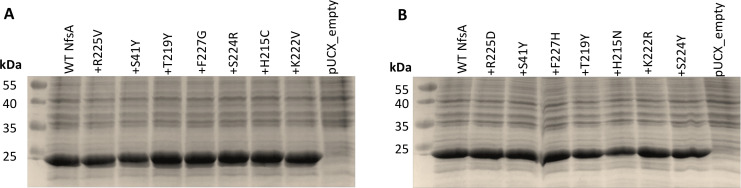
Relative enzyme expression levels for key intermediates from the most plausible hypothetical evolutionary trajectories for (A) 36_37 and (B) 20_39.Overnight E. coli 7NT cultures expressing pUCX::nfsA constructs were used to inoculate LB medium amended with 50 µM IPTG and incubated for 6.5 hr at 30°C. Samples were normalised based on cell density (OD600). On each gel, lysate from the cells expressing wild-type nfsA was loaded in the left-most lane relative to the markers, then the strain expressing the R225V/D mutant, then the S41Y R225V/D double mutant, and so on, as indicated by the labels denoting each successive substitution. An E. coli strain bearing empty pUCX was included in the right-most lane of each gel as a negative control. The predicted molecular mass of NfsA is 26.8 kDa.